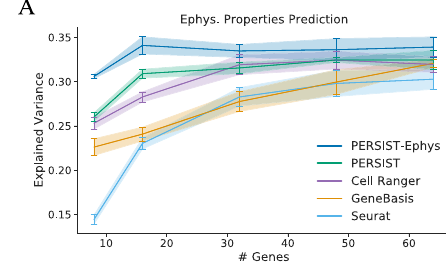
Fig. 4 | Using PERSIST to predict electrophysiological properties. PERSIST is adapted to this speci fi c experimental goal by using electrophsyiological char- acteristicsasits prediction target. The resulting version of our approach, PERSIST- Ephys, yields gene panels can predict cells' electrophysiological properties more accurately than other methods. A Explained variance in the electrophysiological propertiesfor gene panelsselected by each method. Results were calculated using